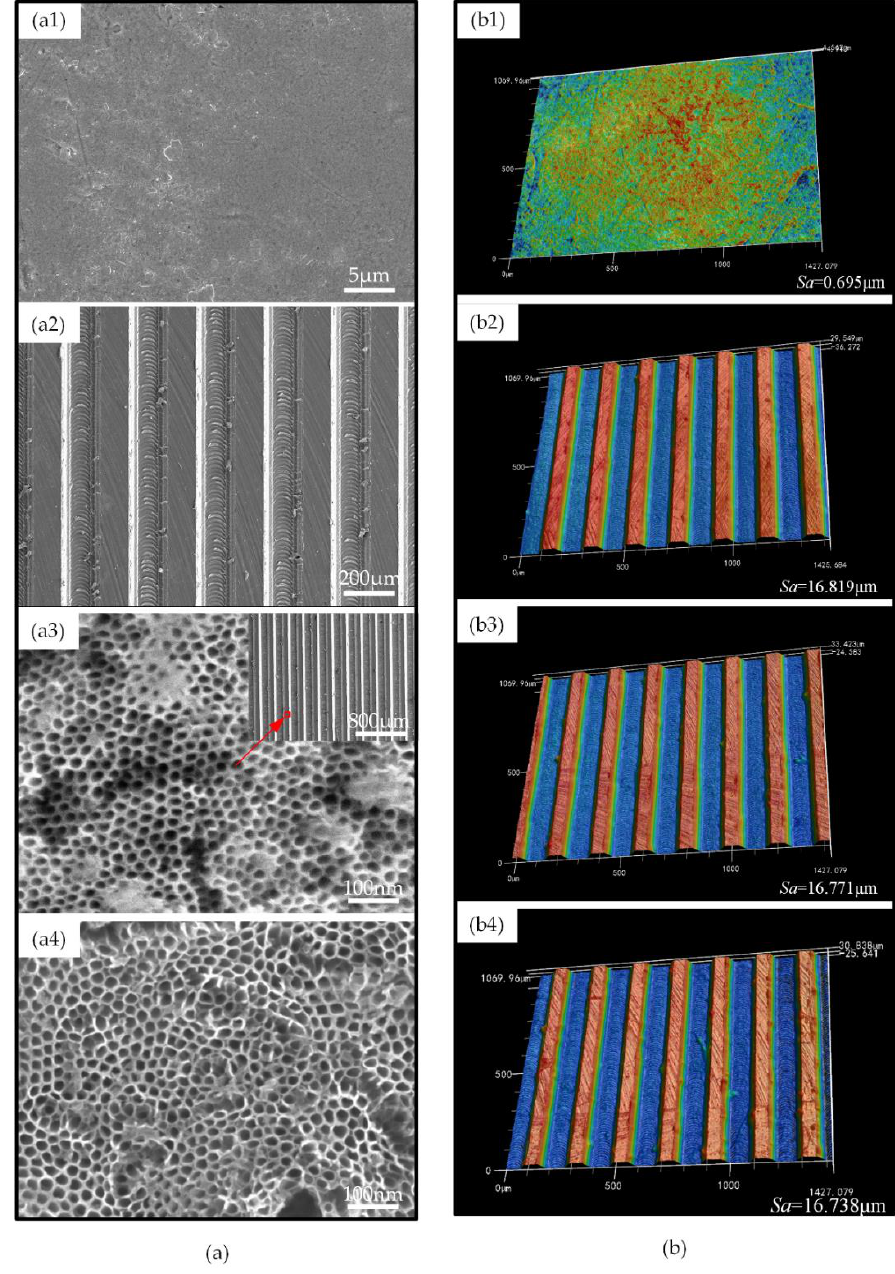
Figure 3. ( a ) Scanning electron microscope (SEM) images of ( a1 ) P Ti, ( a2 ) M Ti, ( a3 ) MN Ti, ( a4 ) F Ti. ( b ) laser scanning microscope (LSM) images of ( b1 ) P Ti, ( b2 ) M Ti, ( b3 ) MN Ti, ( b4 ) F Ti.